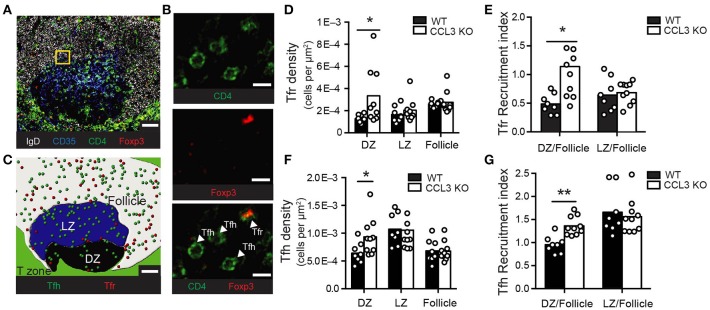
CCL3 is not required for Tfr or Tfh cells recruitment into the GC light zone. Immunofluorescent analysis of Tfr and Tfh cell localization in the GCs and follicles of draining pLNs from WT or CCL3-KO mice at 10 d.p.i. with 50 μg OVA in Ribi. (A–C) Representative example of a confocal image of pLN section and its analysis. (A) Confocal image of a GC-containing 10 μm section of pLN from WT mouse, stained with antibodies against IgD (white), CD35 (blue), CD4 (green) and Foxp3 (red). (B) Magnified image from the inset (in A) that illustrates how Treg (CD4+Foxp3+) and Th (CD4+Foxp3−) cells were identified. (C) Reconstruction of GC light zone (blue area), dark zone (black area), follicle (white area), Tregs (red circles) and Th cells (green circles) within the confocal image shown in (A) using manually defined surfaces in Imaris. Scale bars: 50 μm in (A,C) and 10 μm in (B). (D–G) Quantitative analysis of Treg (D,E) and Th (F,G) cell abundance in the GCs and the follicles. Density of Tregs (D) and Th cells (F) in GC dark zone (DZ), light zone (LZ) and follicles around GCs calculated as the number of T cells in each zone normalized to the total area of that zone. Recruitment index calculated as the density of Tregs (E) or Th cells (G) in GC DZ or LZ normalized to their density in the GC-containing follicle. (D–G) Each symbol represents analysis of pLN section with a distinct GC. Data represents n = 3 independent experiments with 4 total mice per genotype. Bars represent mean. *P < 0.05, two-tailed Student's t-test.